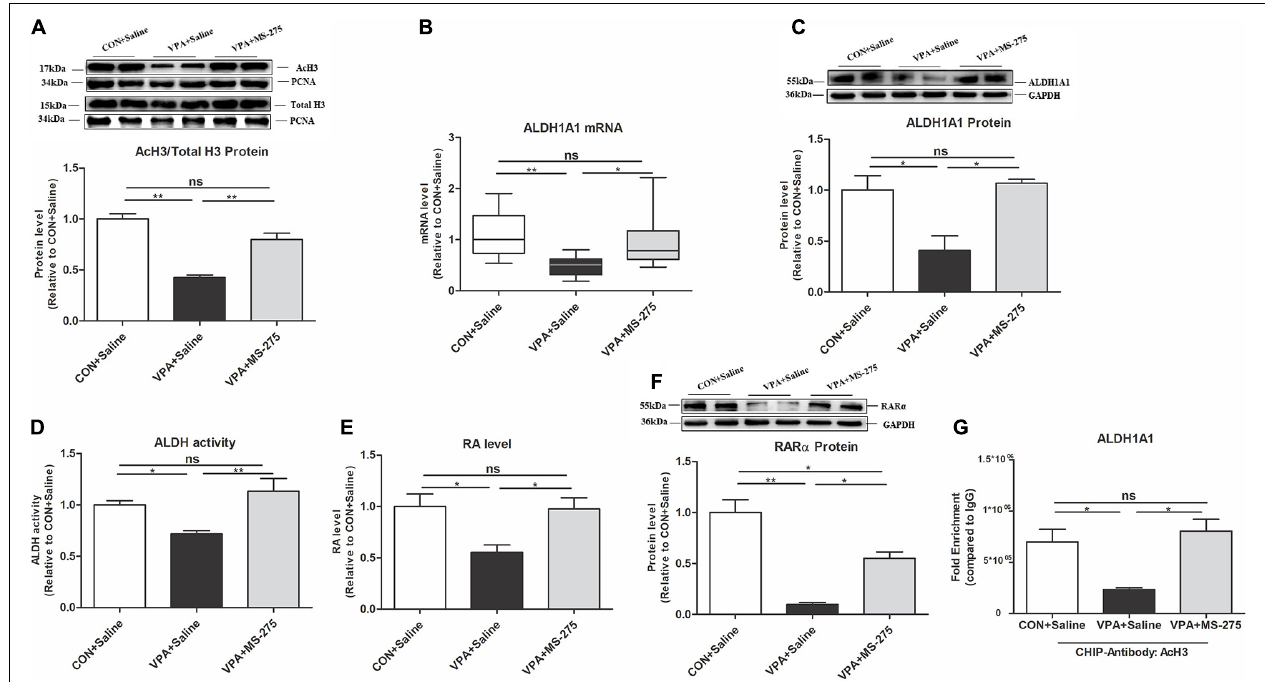
FIGURE 5 | Levels of AcH3, ALDH1A1, and RA-RAR α expression in the PFC of VPA-exposed offspring following MS-275 treatment. (A) Western blot and quantification analyses of AcH3 and total H3 protein in the nuclear fraction of PFC from the CON + Saline, VPA + Saline, and VPA + MS-275 groups, as normalized to PCNA; the level of histone acetylation was measured as the ratio of AcH3 to H3 ( n = 3 per group). (B) ALDH1A1 mRNA expression in the PFC from the CON + Saline, VPA + Saline, and VPA + MS-275 groups, as detected using qPCR and normalized to GAPDH ( n = 10 per group). (C) Western blot and quantification analyses of ALDH1A1 protein in the PFC of offspring from the CON + Saline, VPA + Saline, and VPA + MS-275 groups ( n = 3 per group). (D) ALDH enzyme activity in PFC tissue from the CON + Saline, VPA + Saline, and VPA + MS-275 groups was determined using the ALDH Assay Kit ( n = 10 per group). (E) RA levels in the PFC from the CON + Saline, VPA + Saline, and VPA + MS-275 groups, as quantitated using UPLC-MS/MS ( n = 5 per group). (F) Western blot and quantification analyses of RAR α protein in the PFC from the CON + Saline, VPA + Saline, and VPA + MS-275 groups ( n = 3 per group). (G) ChIP-qPCR analyses of the enrichment of AcH3 on the promoter region of the ALDH1A1 gene in the PFC from the CON + Saline, VPA + Saline, and VPA + MS-275 groups ( n = 3 per group). Each experiment was repeated at least three times. The values are the means ± SEMs (A,C–G) or median (P25–P75) (B) . One-way ANOVA with Bonferroni post hoc test (A,C–G) , Kruskal–Wallis H test with Nemenyi post hoc test (B) , * P < 0.05, ** P < 0.01, ns, not significant; VPA, valproic acid; PFC: prefrontal